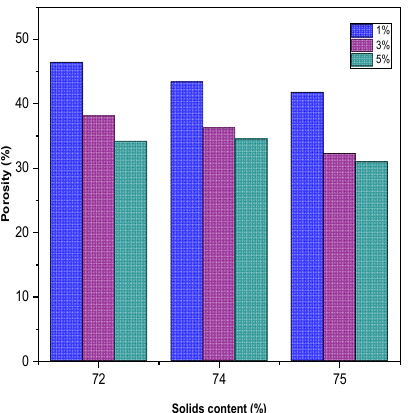
Figure 11. Effect of porosity on different solids contents and cement ratio.